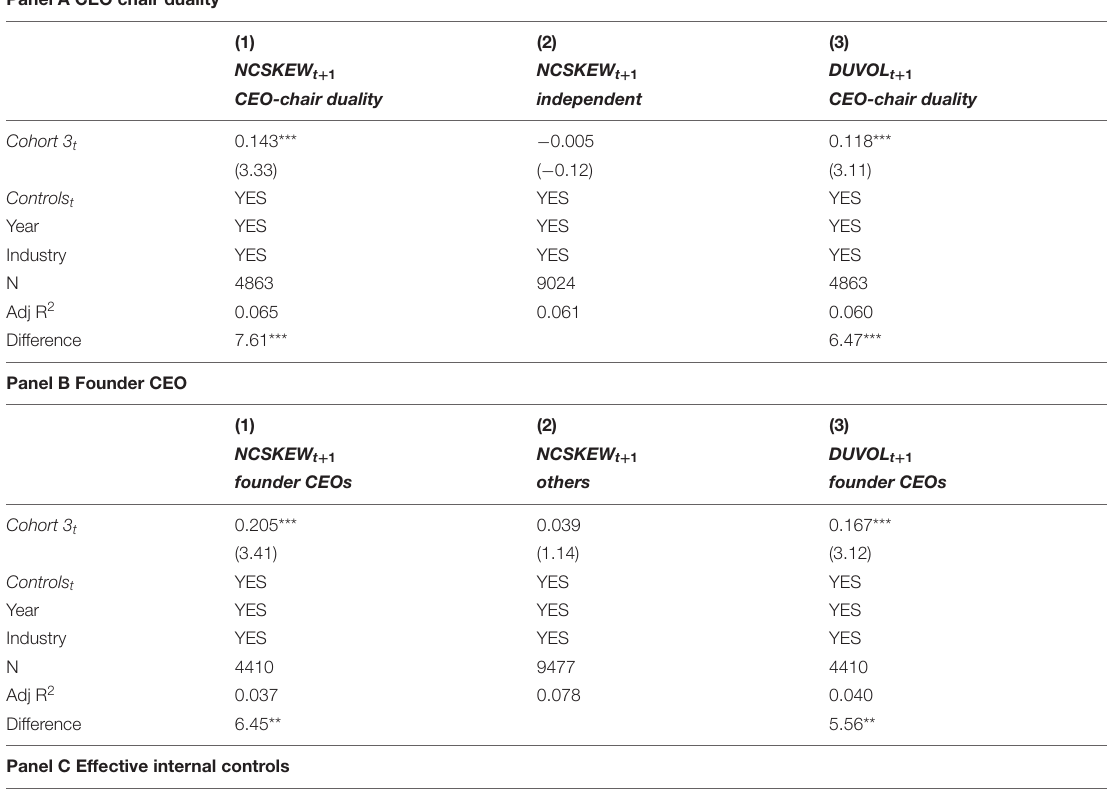
TABLE 15 | Moderating effect of CEO power. Panel A CEO chair